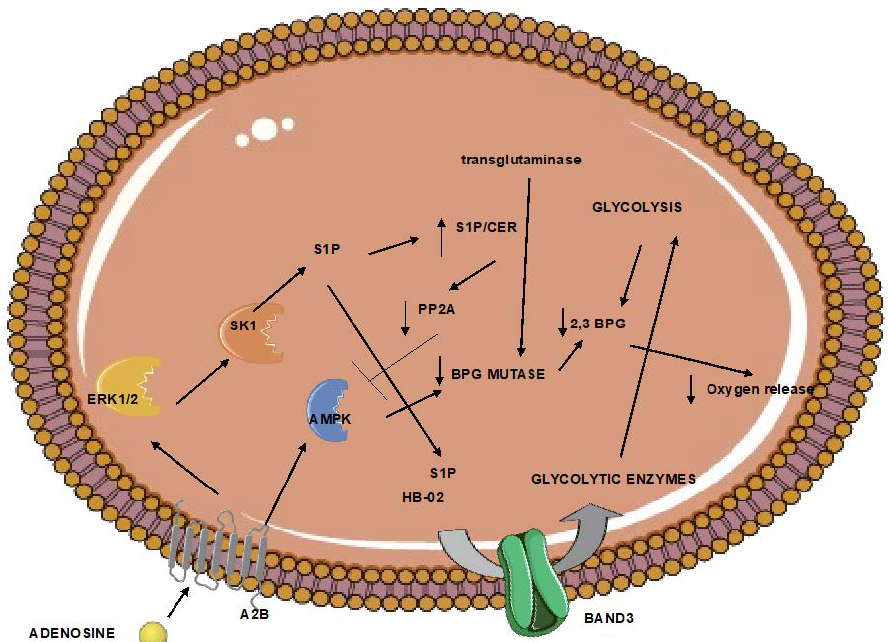
Figure 2. Erythrocytes trapped in the ischemic tissue can respond to limited oxygen through the regulation of the 2,3-bisphosphoglycerate. However, aging and obesity halter this pathway. The end result can be increased brain inflammation. (A normal arrow signifies activation. An arrow with a vertical line signifies inhibition). 2,3 BPG: 2,3 biphosphoglycerate; A2B: adenosine receptor 2B; AMPK; adenosine monophosphate-activated kinase, BPG mutase: biphosphoglycerate mutase; CER: ceramide; ERK1/2: extracellular signal-regulated kinase; HB-O2: oxygenated hemoglobin; S1P: sphingosine-1 phosphate; SK1: sphingosine kinase 1.